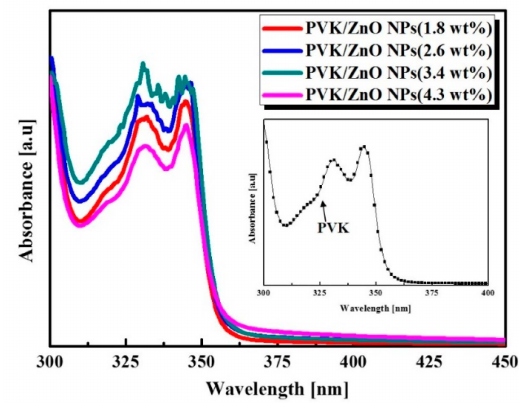
Figure 3. UV-vis absorption spectra of PVK/ZnO NPs hybrid composites and inset image is PVK optical properties.